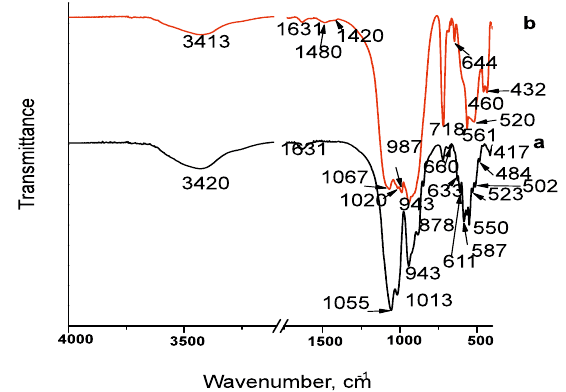
Figure 2. FTIR spectra of CPS-1 (a) and CPS-2 (b) samples, heat treated at 1200 o C / 2